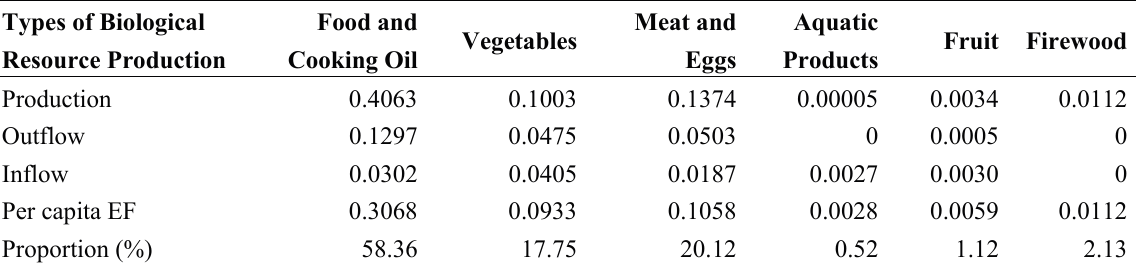
Table 2. The EFs of farmers’ consumption of biological resource products in Guyuan in 2012 (ha/cap).